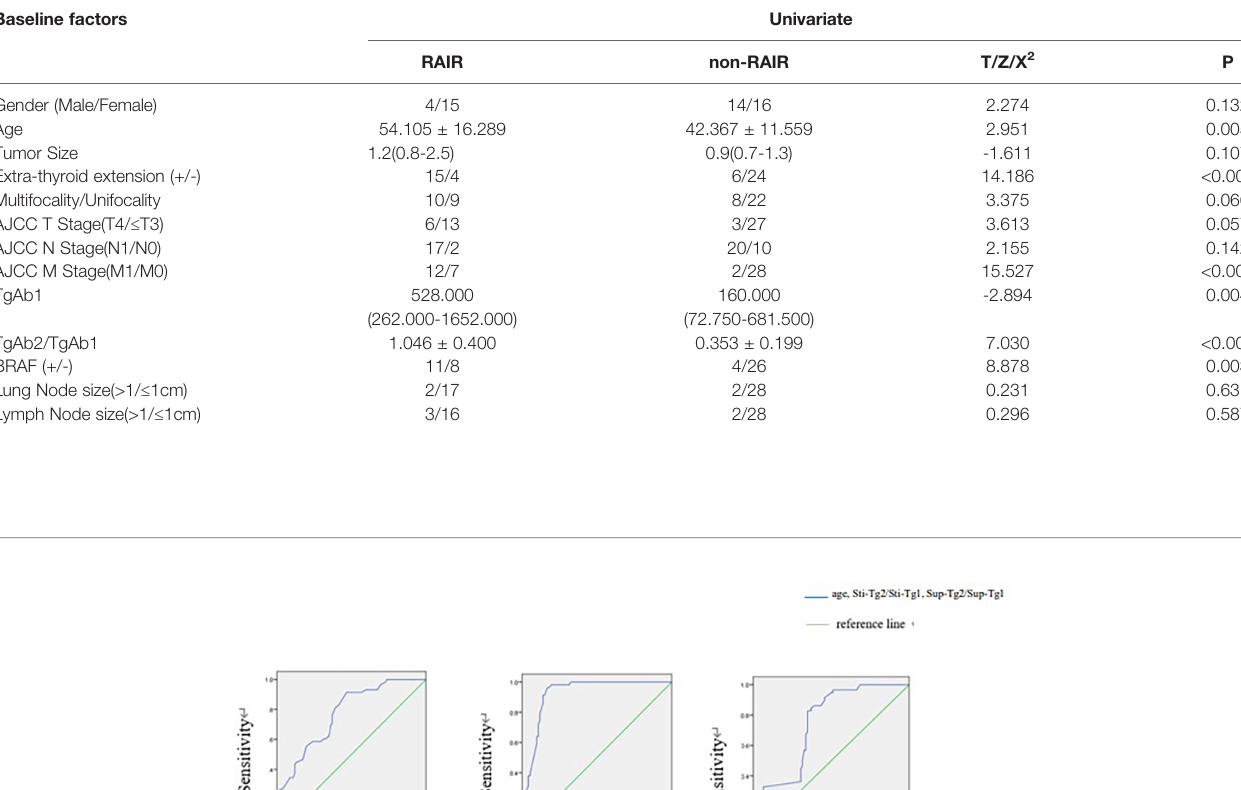
TABLE 3 | Univariate analysis of the factors in the TgAb positive group. Baseline factors